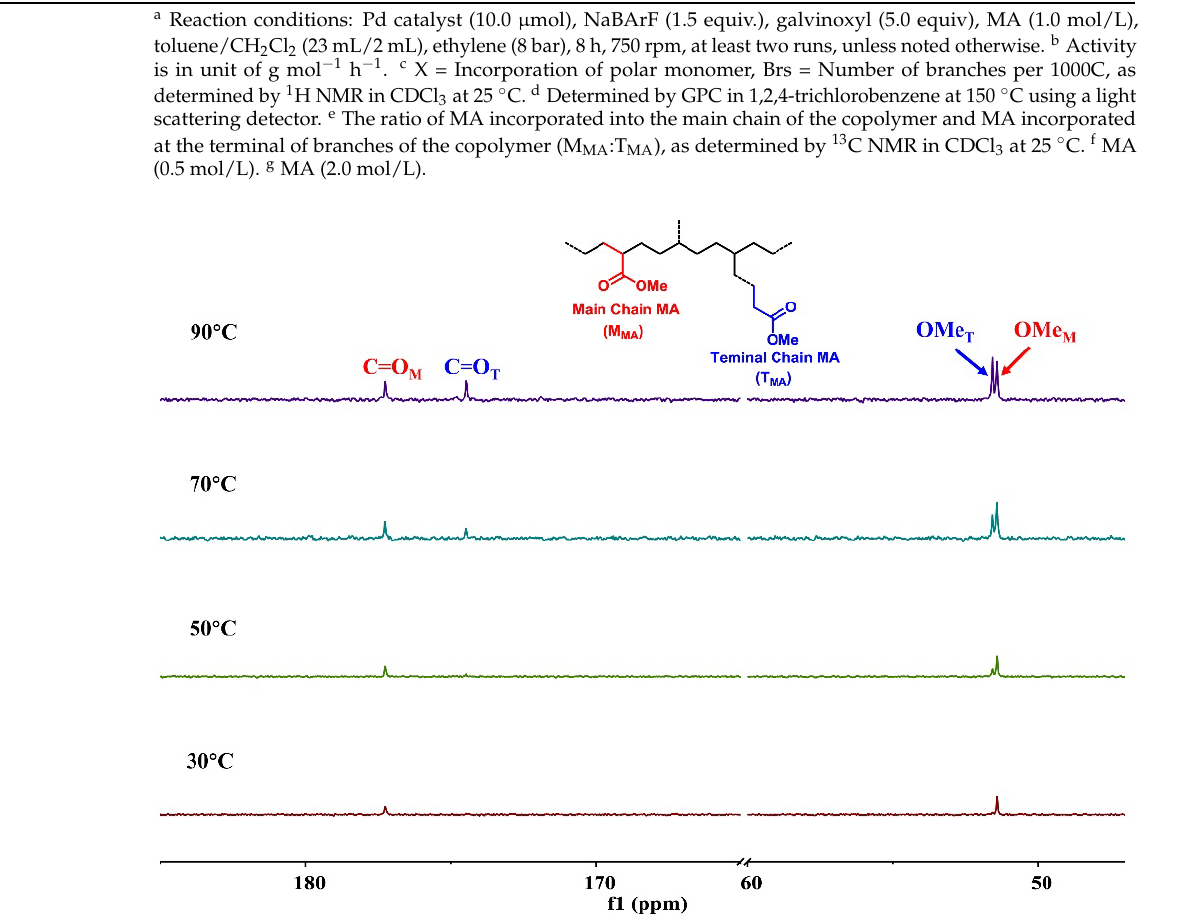
Figure 6. Comparison of C=O and OMe resonances (45–60 ppm and 165–185 ppm) of M MA and T MA at different reaction temperatures (30, 50, 70, and 90 °C; Table 5, entries 1–4) in the 13 C NMR spectra (500 MHz, 293 K, CDCl 3 ) of ethylene-MA copolymers.